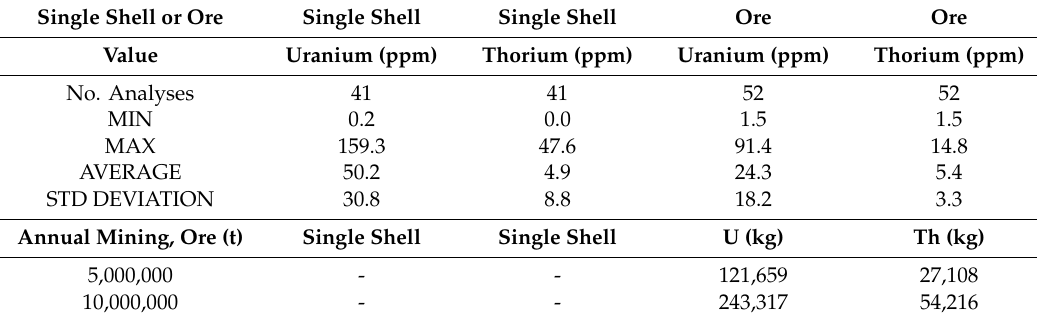
Table 5. Minimum, maximum, average and standard deviation of U and Th contents in analyzed brachiopod shells and phosphate ore. As an example, U and Th contents for mining activity with di ff erent annual amounts have been calculated as a possible